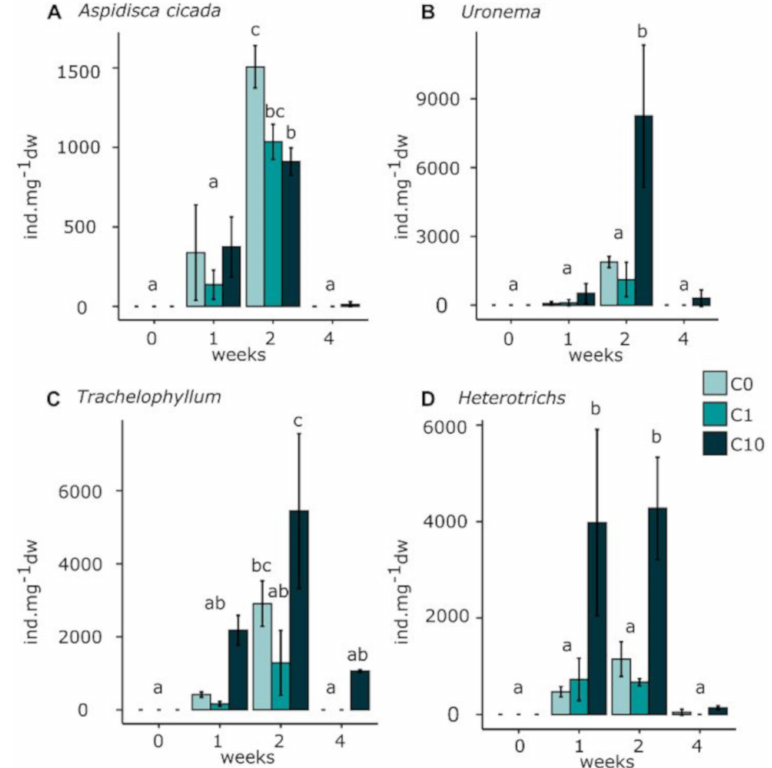
Figure 4. Ciliates Aspidisca cicada [29], Uronema sp., Trachelophyllum sp., and undefined heterotrich species individuals present per mg of biofilm dry weight in control (C0 = 0.2 ± 0.1 nM) and Zr exposures (C1 = 0.5 ± 0.3 nM and C10 = 2.9 ± 0.3 nM). Values are means and standard errors. A two-way ANOVA was performed to detect significant differences between treatments as indicated by letters ( p < 0.05; n =